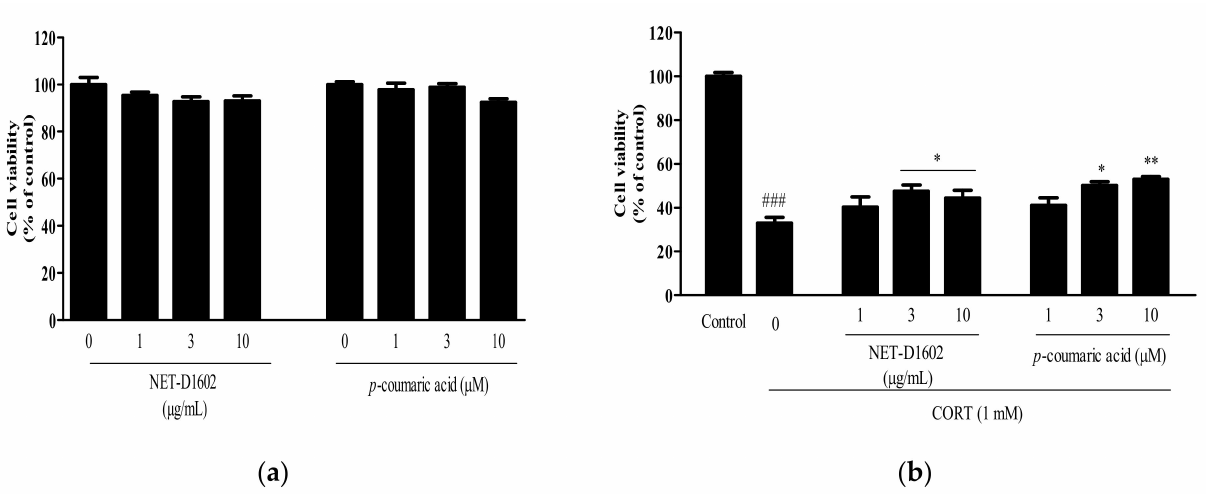
Figure 2. Effects of NET-D1602 and p -coumaric acid on the viability of CORT-induced SH-SY5Y cells. ( a ) Treatment with various concentrations of NET-D1602 and p -coumaric acid for 24 h. ( b ) Pretreatment with NET-D1602 (1, 3, and 10 µ g/mL) and p -coumaric acid (1, 3, and 10 µ M) for 6 h and subsequent treatment with CORT (1 mM) for 24 h in the absence or presence of NET-D1602 and p -coumaric acid. The values are expressed as the mean ± standard error of the mean ( n = 3). ### p < 0.001 compared to that of the untreated group; * p < 0.05 and ** p < 0.01 compared to that of the CORT group. CORT, corticosterone; NET-D1602, HP-20 resin fraction of the water extract of Vaccinium bracteatum